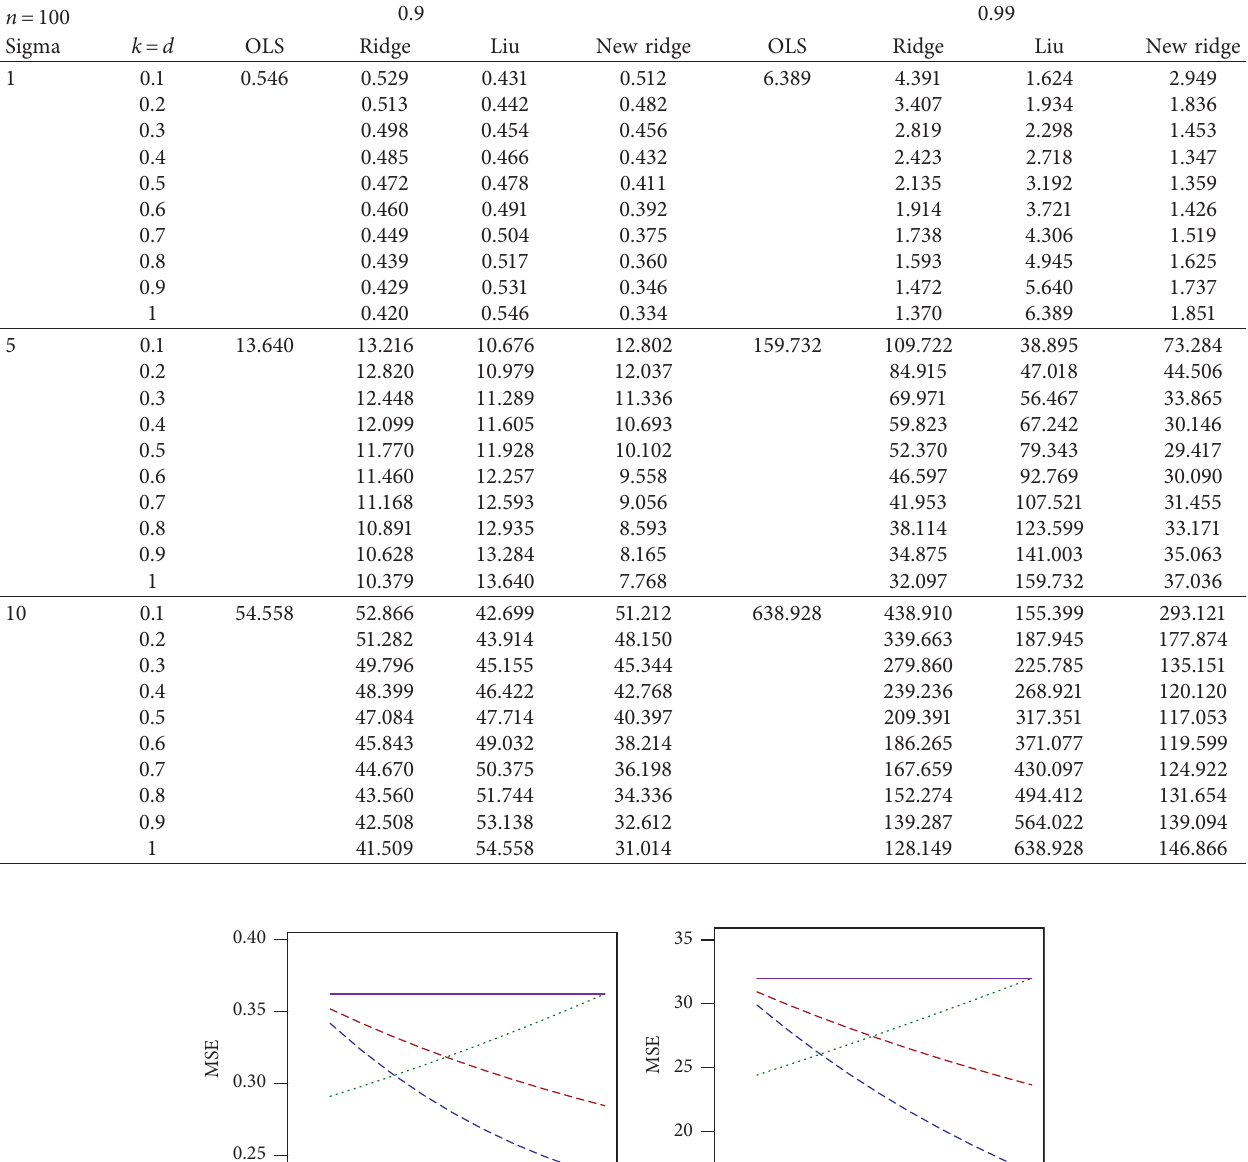
Table 8: Estimated MSE when n � 100, p � 7, and ρ � 0.90 and